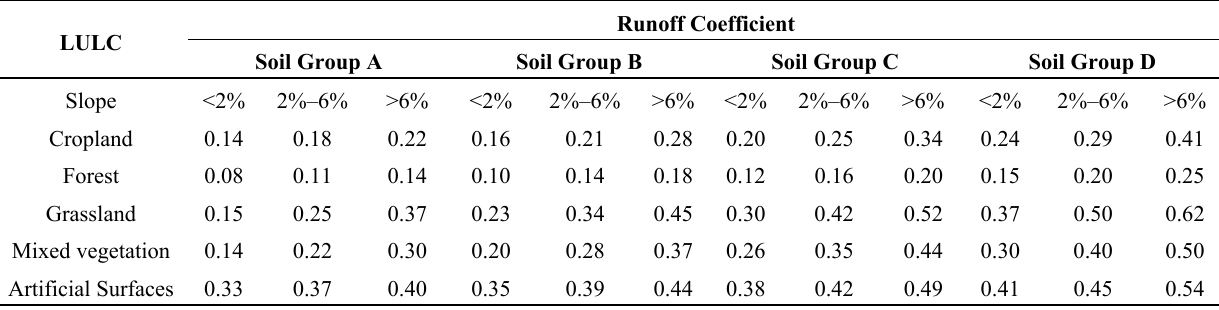
Table 2. Rational method runoff